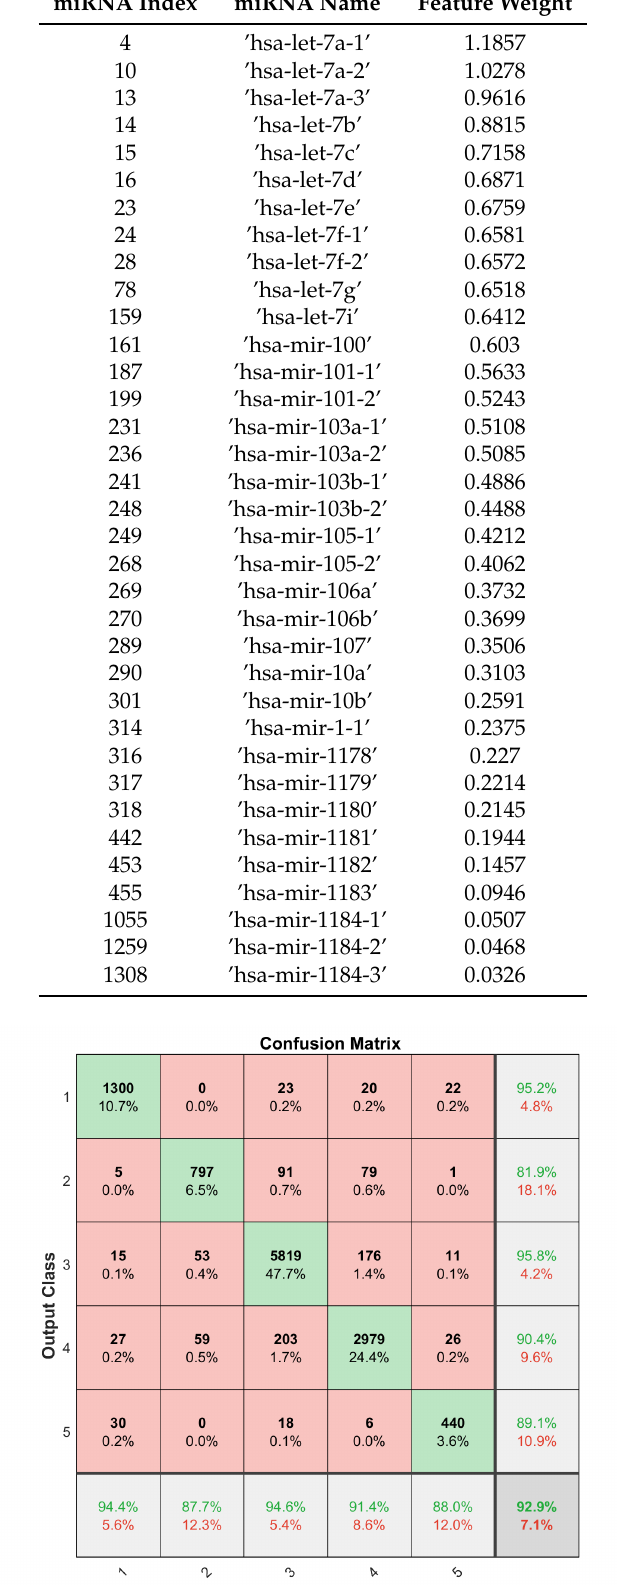
Table 2. Selected miRNA names and index with corresponding feature weights.